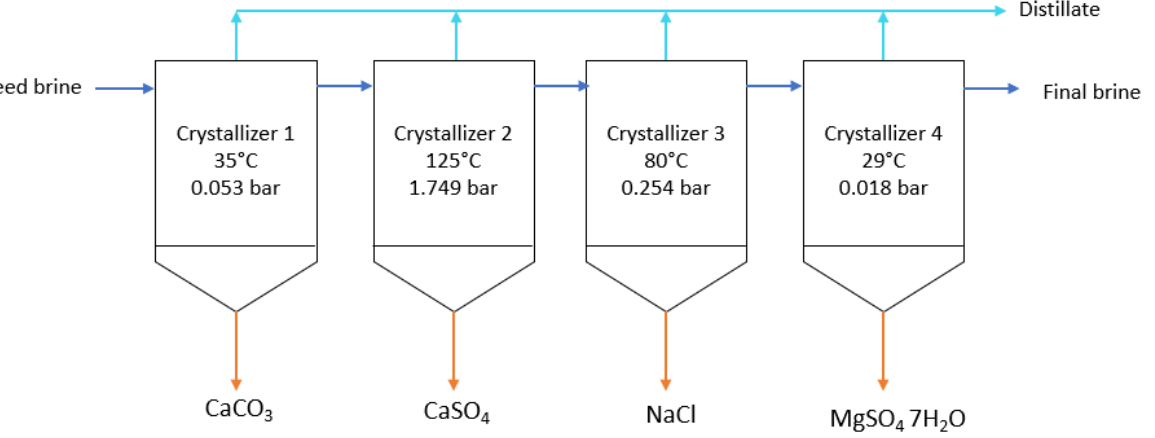
Figure 2. Schematic of the multi-crystallization system concept.